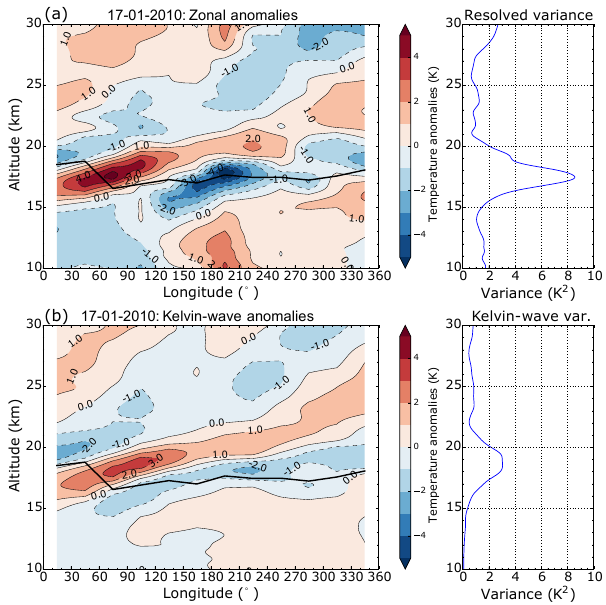
Figure 2. Zonal- (top) and Kelvin-wave (bottom) temperature anomalies as a function of longitude and altitude from 17 January 2010. The black thick line indicates the lapse-rate tropopause. Ver- tical profiles of associated zonal mean variances are plotted on the right-hand side of each